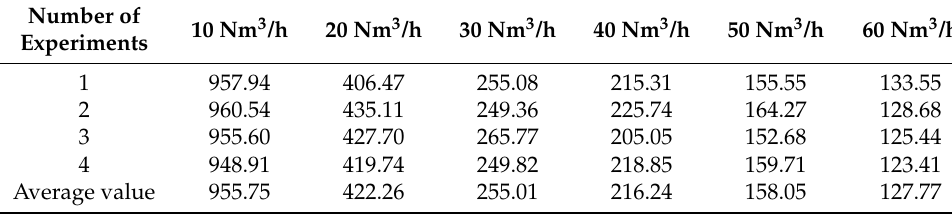
Table 4. Liquid content in Case 1 at M 1 (g/m 3 ).